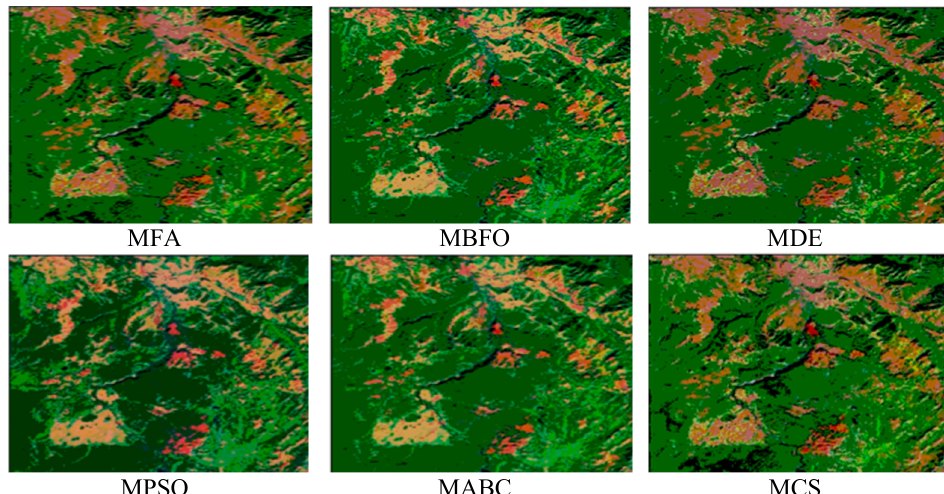
Figure 5. EC-Otsu-function-based segmented images using MFA, MBFO, MDE, MPSO, MABC, and MCS for thresholding level 5.